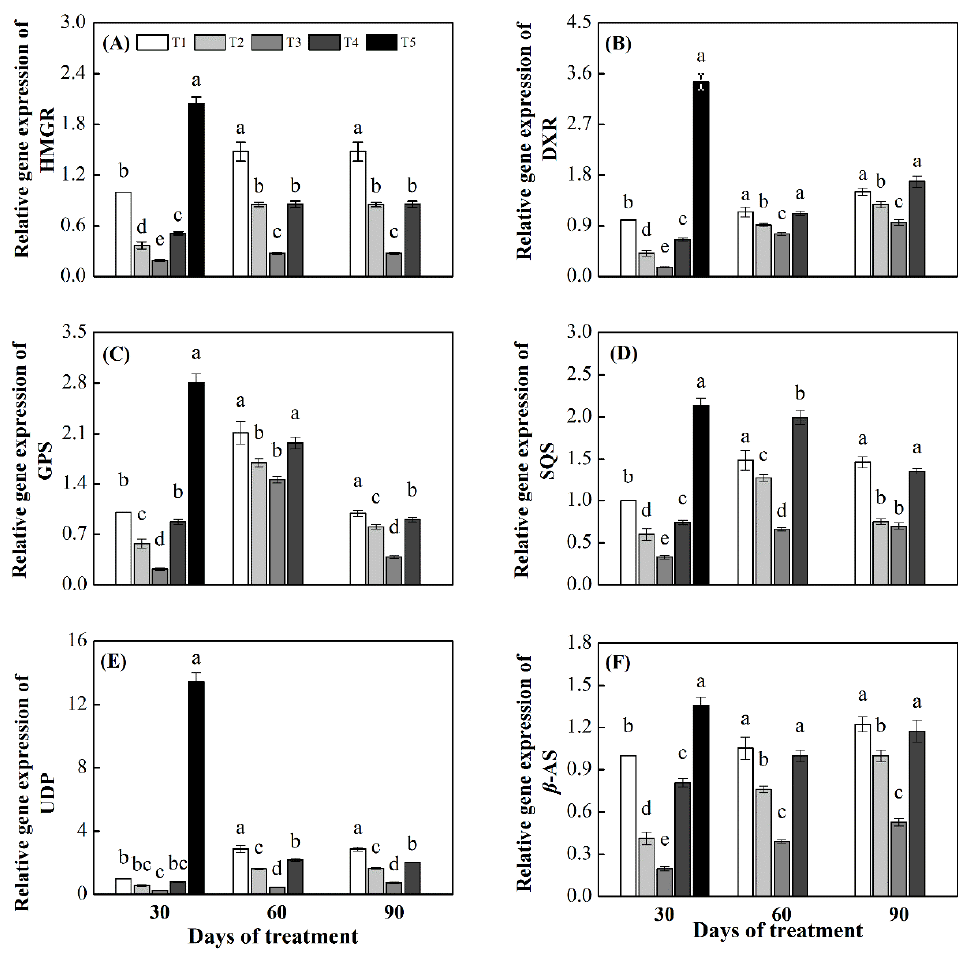
Figure 6. E ff ects of NO 3 − / NH 4 + ratio on relative gene expression of HMGR ( A ), DXR ( B ), GPS ( C ), SQS Figure 6. Effects of NO 3− /NH 4+ ratio on relative gene expression of HMGR, DXR, GPS, SQS, β-AS ( D ), β -AS ( F ) and UDP ( E ) in C. paliurus leaves sampled at 30, 60 and 90 days after treatments. Di ff and UDP in C. paliurus leaves sampled at 30, 60 and 90 days after treatments. Different letters indicate significant differences among different NO 3− /NH 4+ ratio treatments for the same sampling time according to Tukey’s test ( p < 0.05). All C. paliurus seedlings had died at 52 days after the treatment in T5. Table 2. Pearson correlation coefficients ( r value) between triterpenoid content and gene expression in the leaves across the nitrogen treatment periods (n = 39). Gene Expression